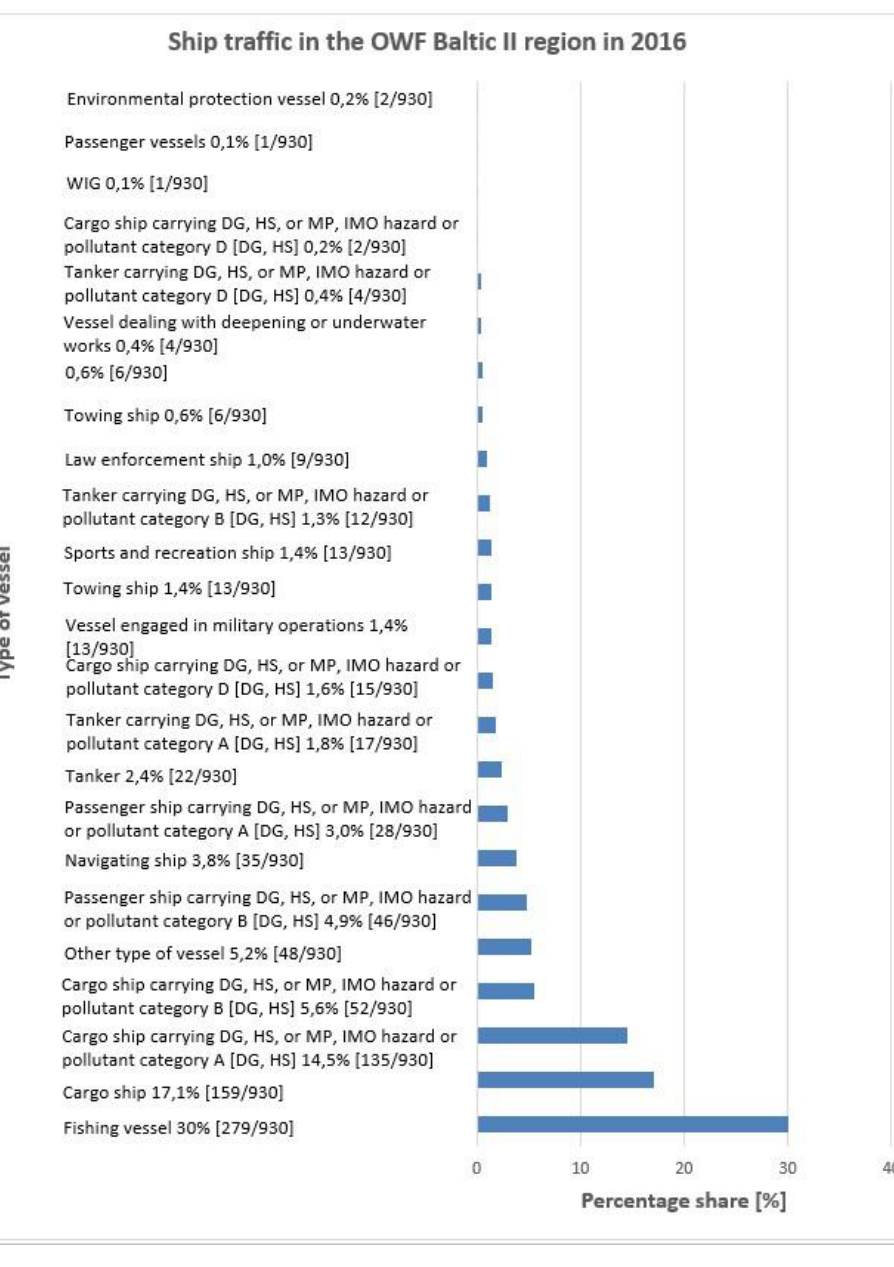
Figure 11. Percentage breakdown of ships by type in 2016.